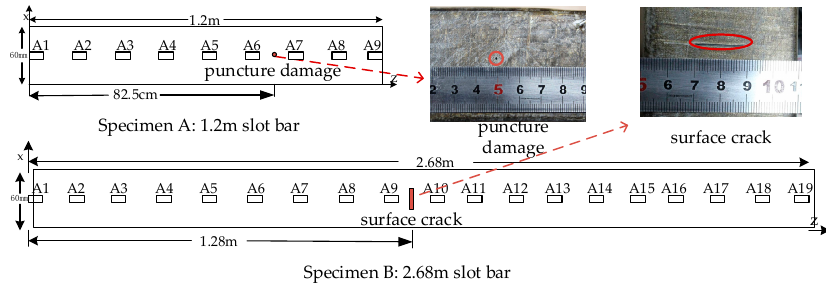
Figure 6. Experimental specimens.